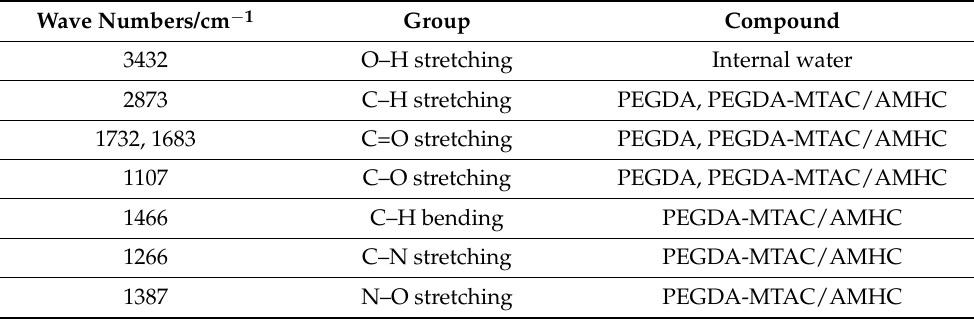
Figure 3. FT–IR spectra of ( a ) PEGDA–MTAC and ( b ) PEGDA–AMHC before and after adsorption of nitrate and nitrite. Table 1. FTIR analyses and peak assignments of both unloaded and loaded